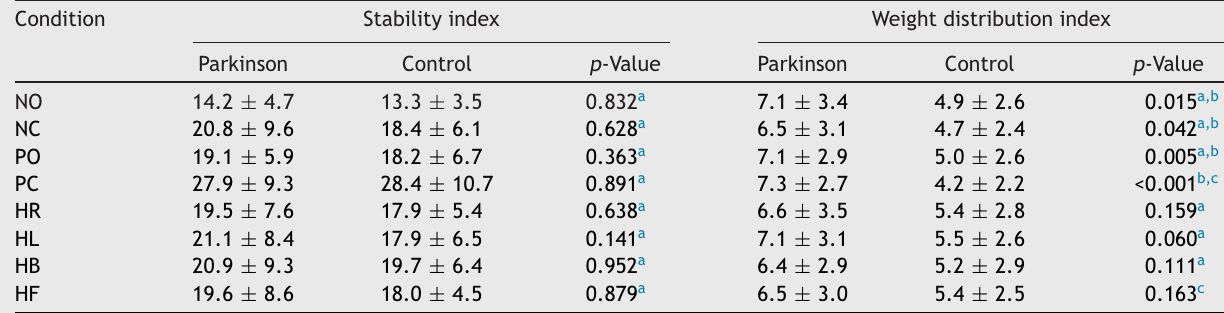
Table 1 Analysis of the stability index and weight distribution index in the eight conditions of the Tetrax TM interactive balance system in 29 control subjects and 30 patients with Parkinson’s